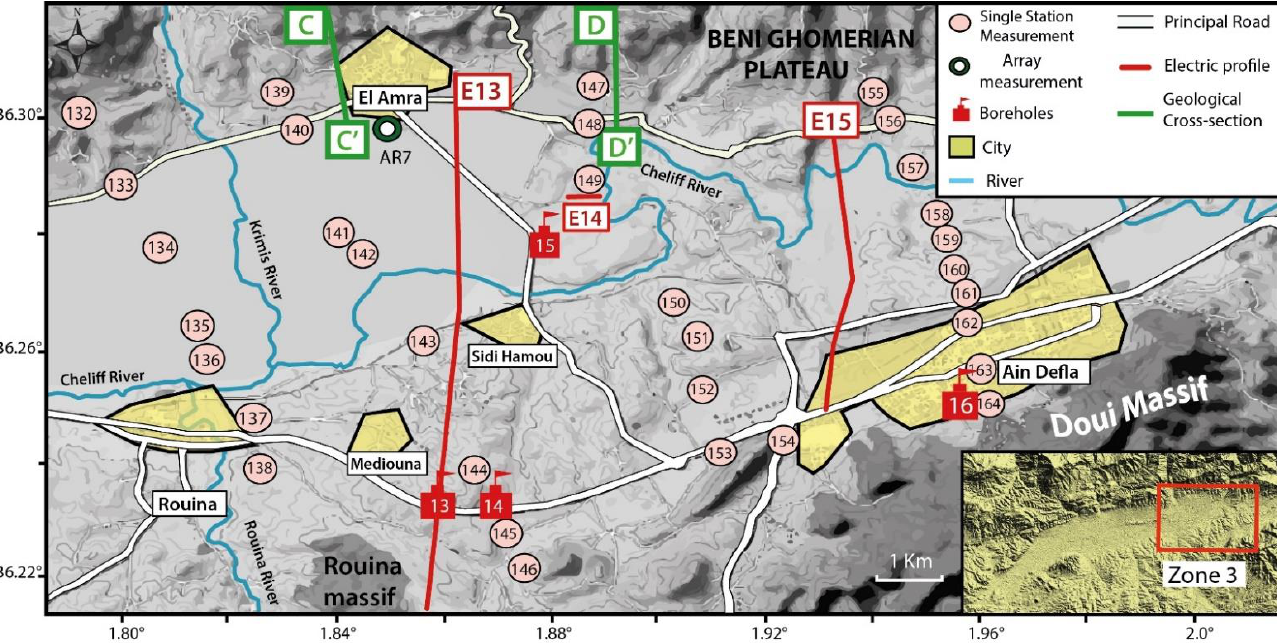
Figure 6. Compiled data in Zone 3.